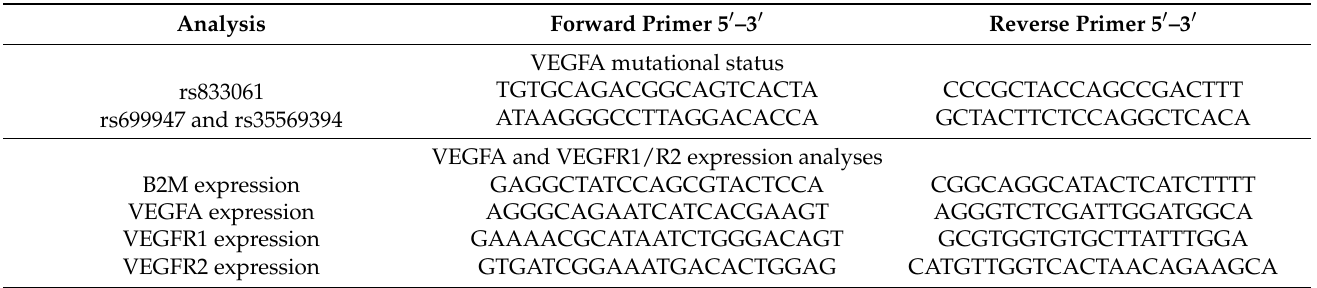
Table 1. Primers’ sequences used for VEGFA mutational status assessment and VEGFA, VEGFR1, and VEGFR2 expression